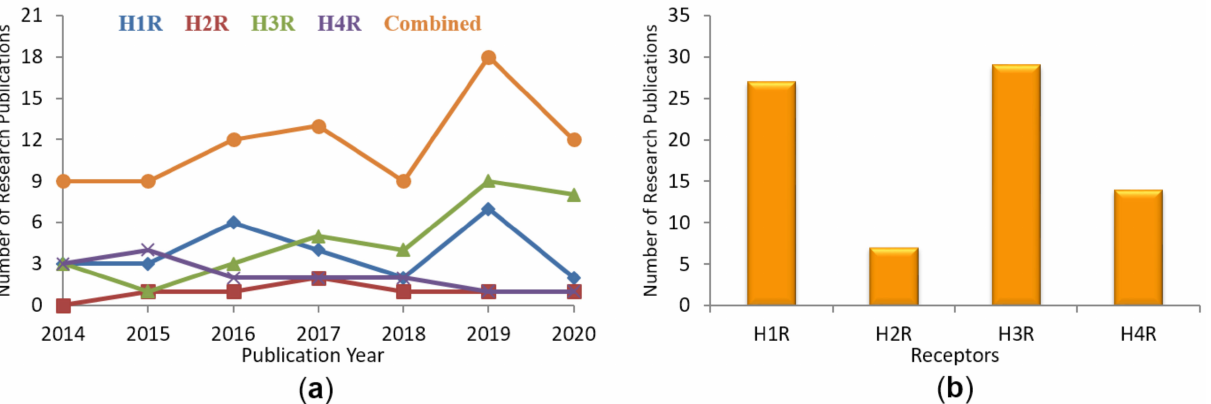
Figure 1. Number of histamine (H 1 –H 4 ) receptor-related computational publications in the 2014–2020 time period: ( a ) Yearly on each HR; ( b ) Total publications on each HR.